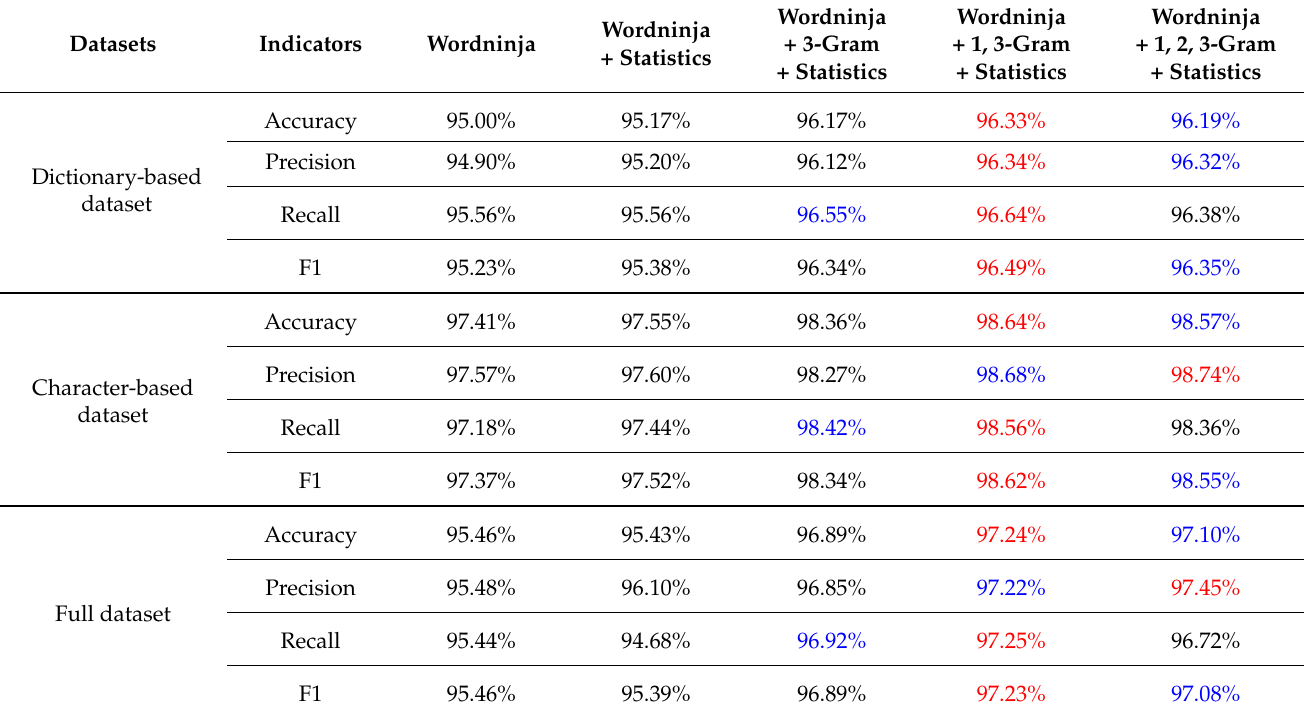
Table 9. Performance of different feature fusion methods.